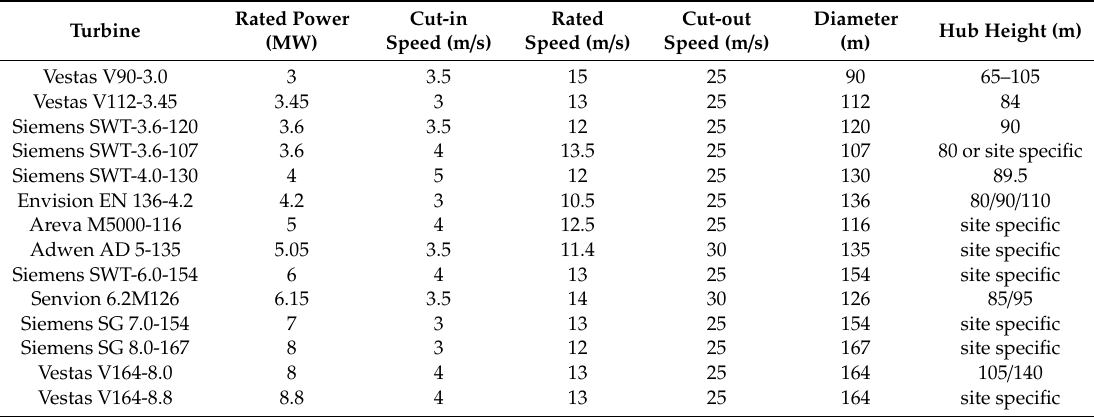
Table 2. The main characteristics of the wind turbines considered